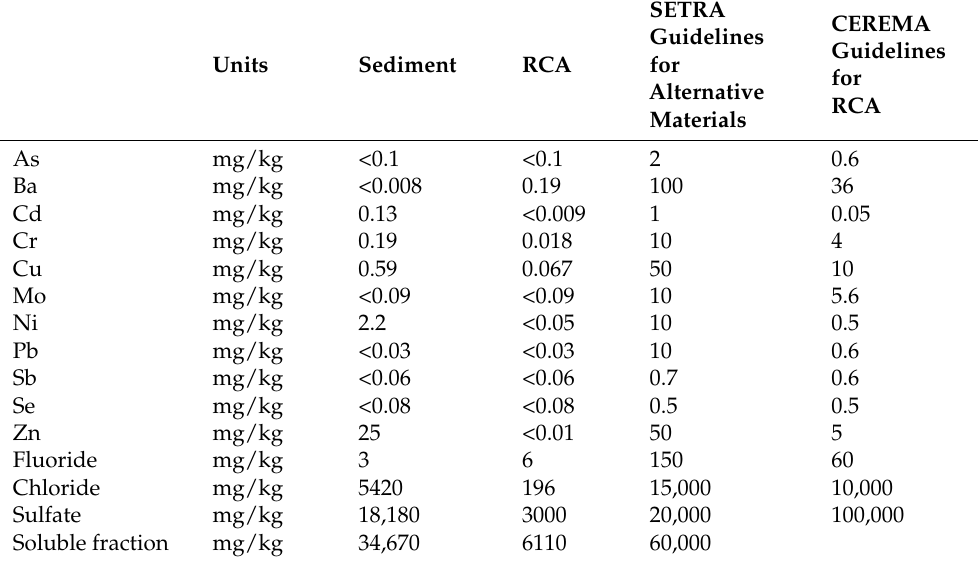
Table 3. Environmental acceptability criteria for road construction.